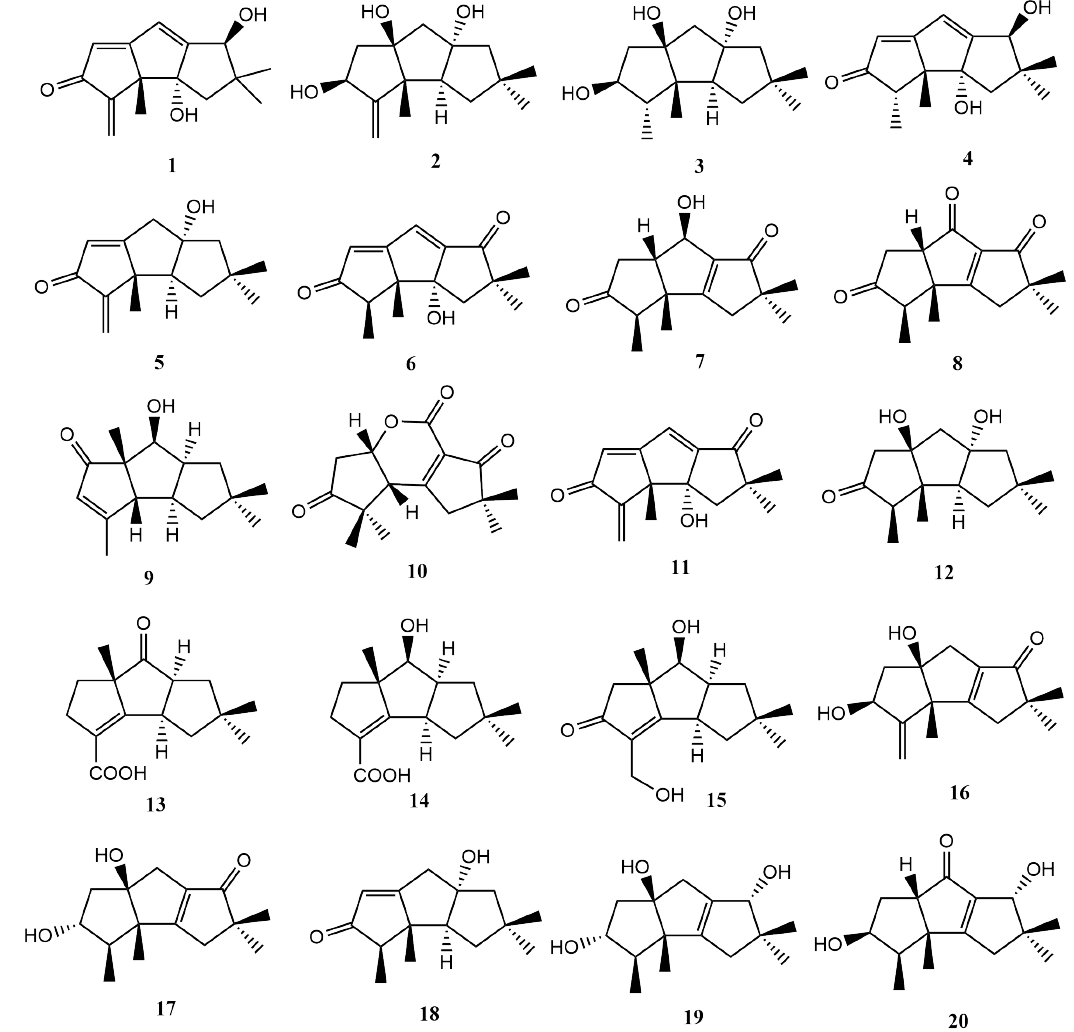
Figure 1. Hirsutanols from Sarcophyton -associated